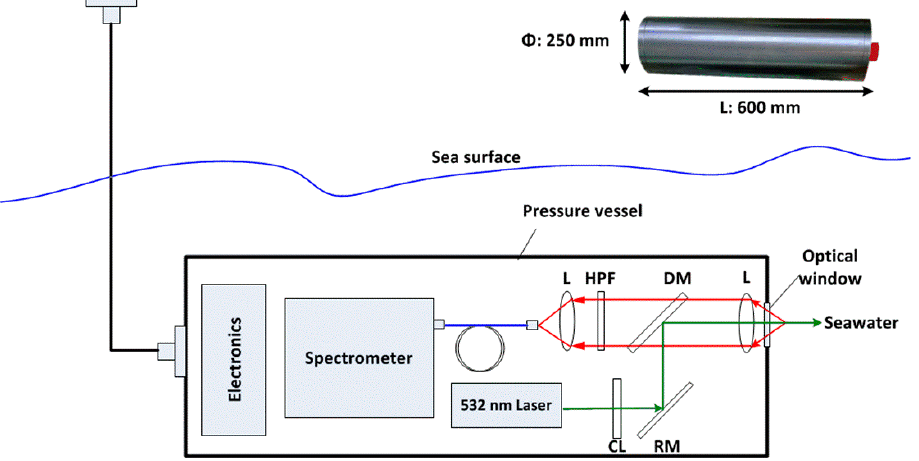
Figure 1. Schematic diagram of the fluorescence-Raman spectral system. (CL, collimator lens; RM, reflecting mirror; DM, dichroic mirror; L, focusing lens; HPF, high pass filter). The size of system is given at the upper right corner.